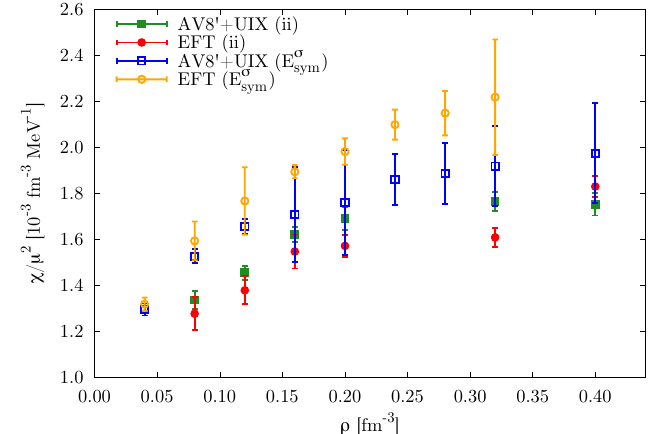
Figure 10. Same as Figure 6 but results are shown for PNM from approach (ii) and from E σ sym